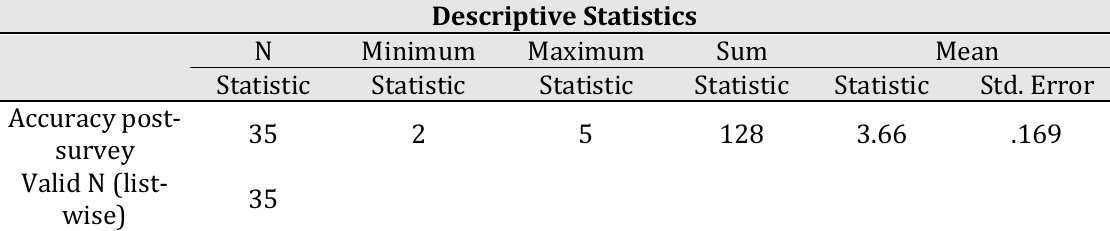
Table 14. Mean Point of Learners’ Accuracy